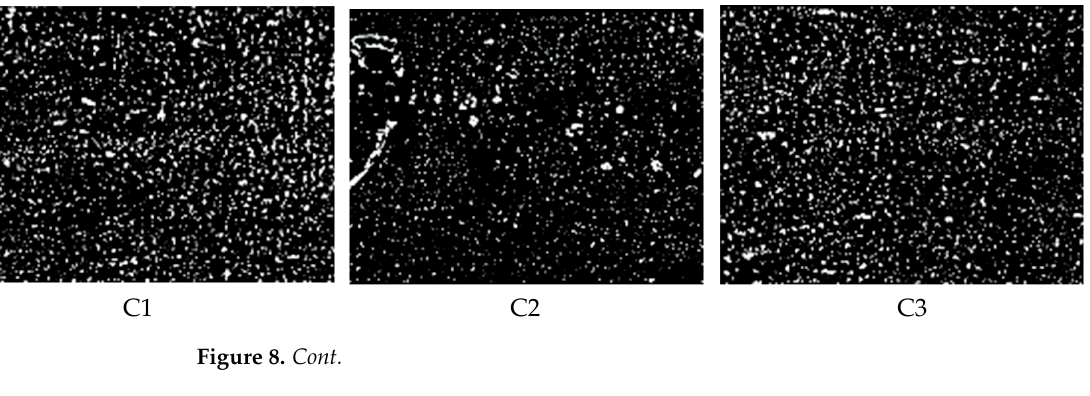
C6 Figure 8. Dispersion images (the scale bar is 100:1). Table 6. Dispersion values. Rubber Compounds